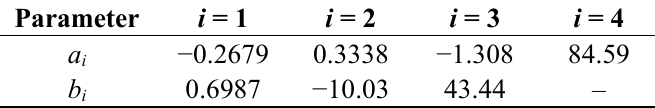
Table 3. Pump characteristic curve